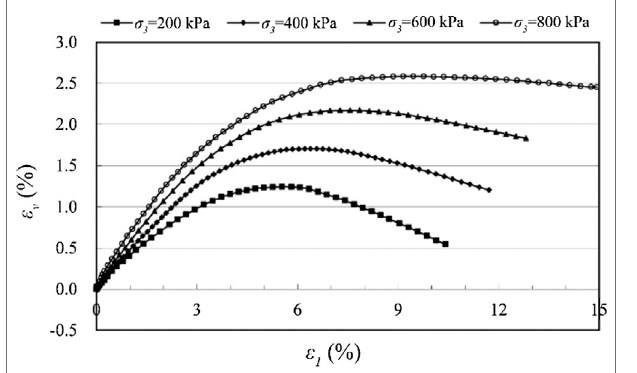
FIGURE 7 | Curves of ( ε 1 ∼ u w ) of saturated sample under different con fi ning pressures (CU).